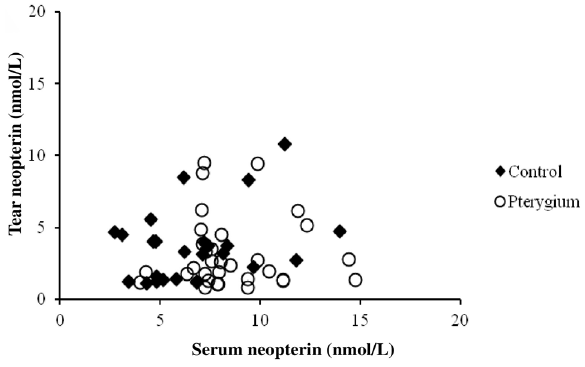
Figure 1: Correlation between serum and tear neopterin levels.